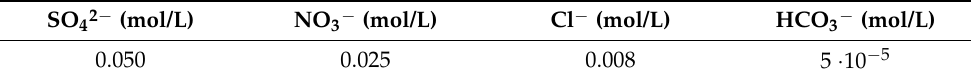
Table 2. Molar concentrations of the ionic species in the synthesised AAPM